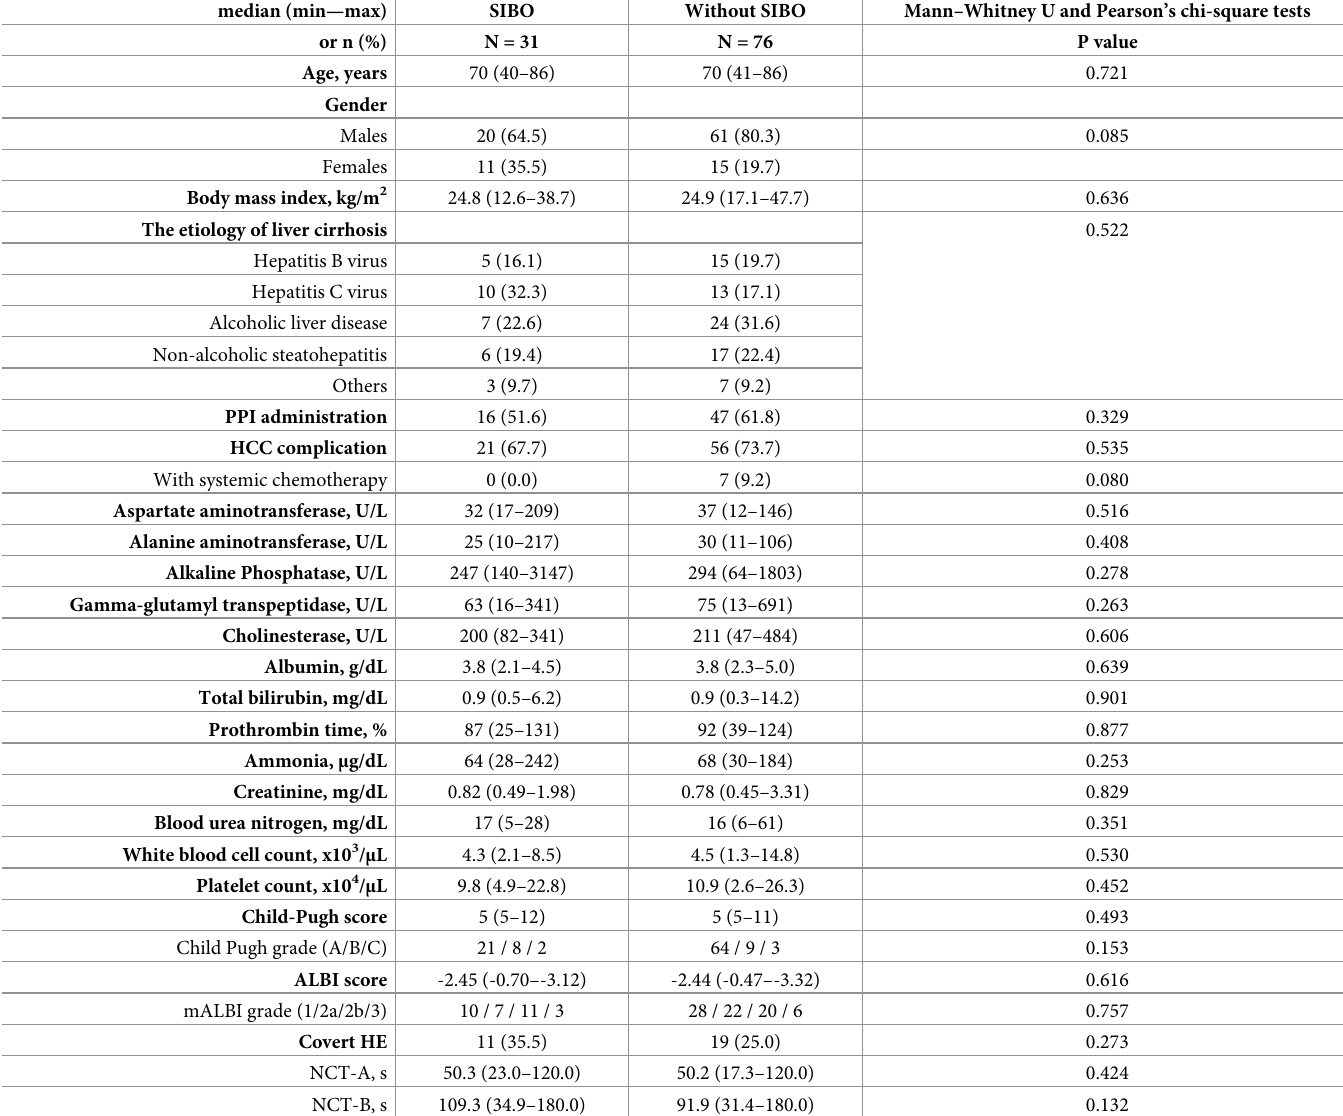
Table 1. The patients’ backgrounds and non-parametric tests clustered by